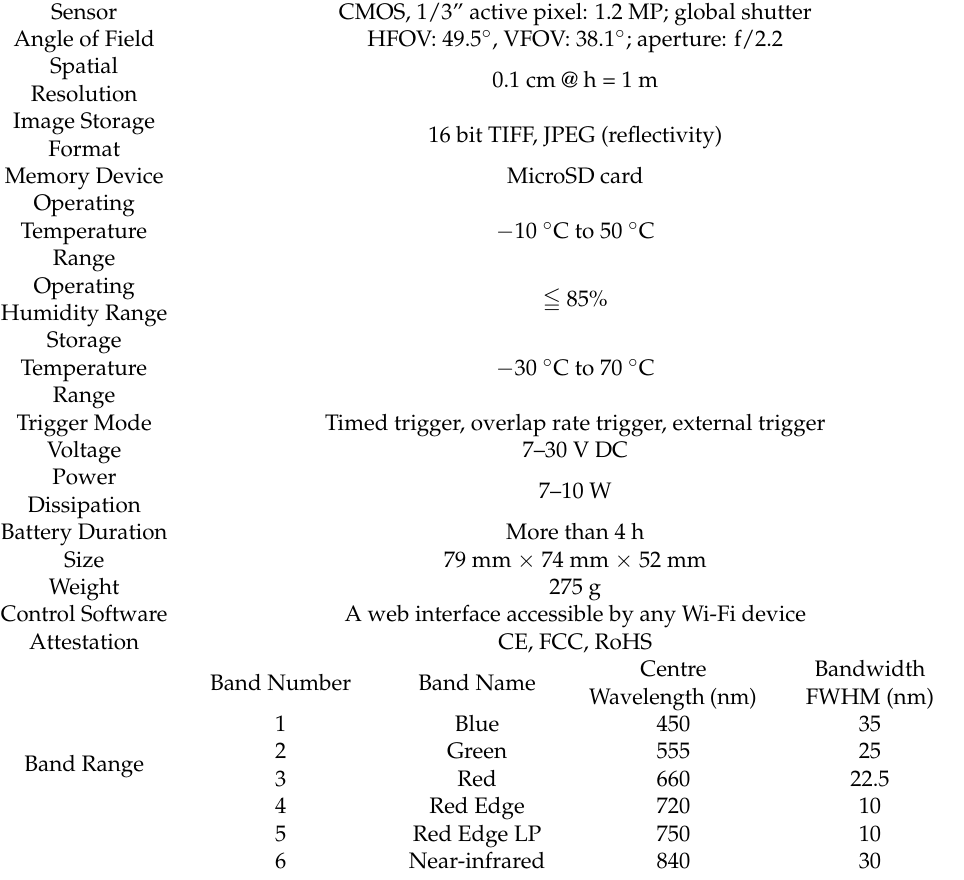
Table 1. Spectral parameters for the multispectral